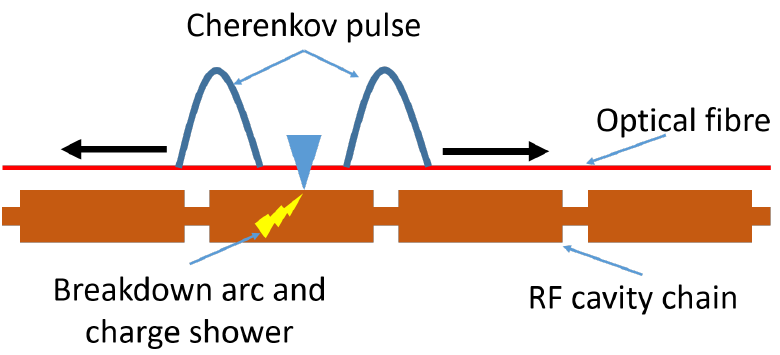
Figure 4. A schematic of a chain of accelerating structures and how the optical fibre system can identify the cavity to cause a